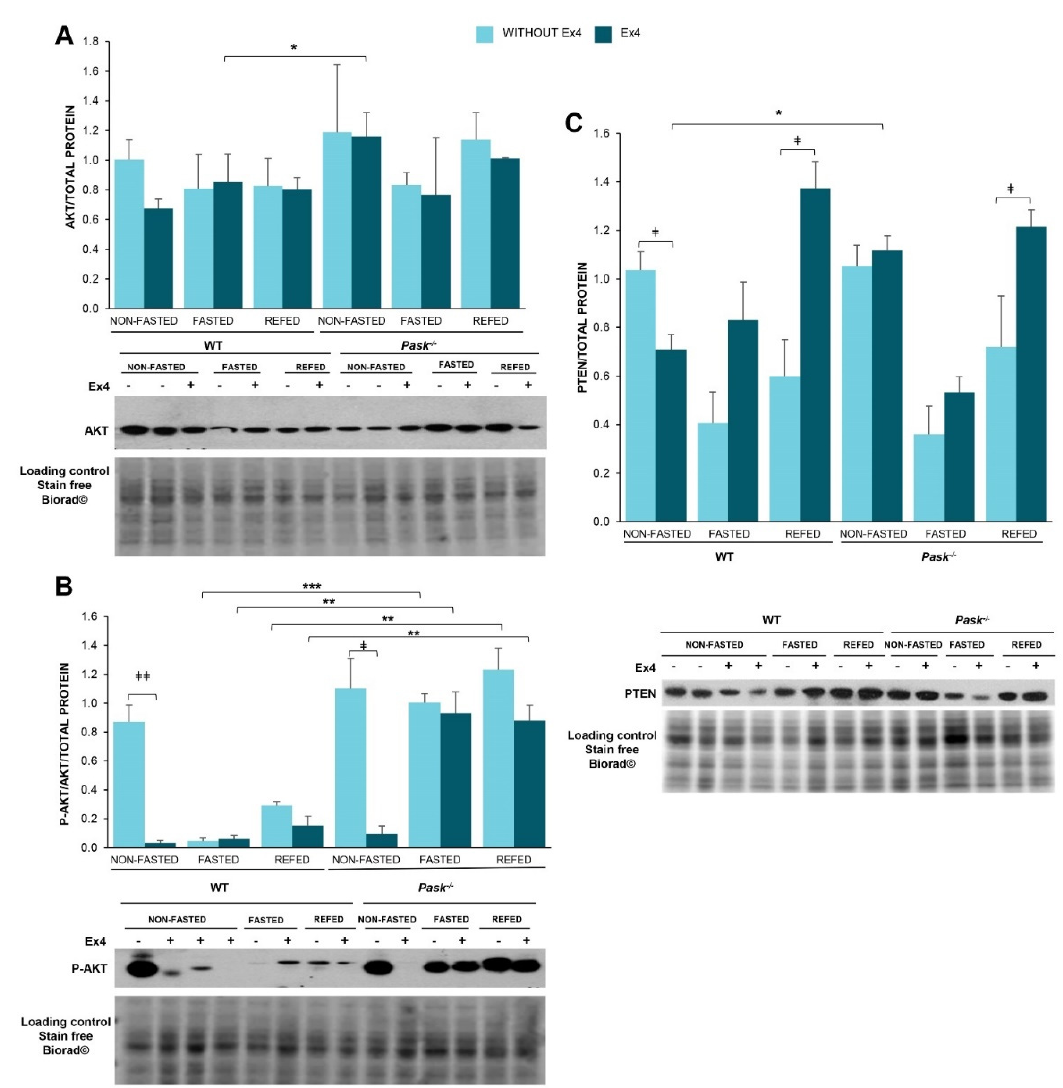
Figure 6. Exendin-4 and PASK-deficiency alter the adjustment of the insulin signaling pathway to fasting or refeeding states. Immunoblot analysis of phospho-AKT (Ser 473) (P-AKT) and total AKT (AKT) ( A , B ) as well as total PTEN (PTEN) ( C ) in the liver from wild-type (WT) and PASK-deficient mice ( Pask − / − ). Liver lysates from non-fasted (NON-FASTED), 48-h fasted (FASTED) and 3-h refed (REFED) specimens in the presence or absence of exendin-4 (Ex4) were processed for Western blot analysis. The values were normalized by total protein detected by Stain-Free Biorad© and expressed as fold-over the non-fasted wild-type mice. A representative blot of 2 prepared blots is also shown, from which the data shown in the graph were collected. Bar graphs show mean ± SEM of 3–5 animals per condition and expressed by fold-over the non-fasted wild-type mice; * p < 0.05, ** p < 0.01, *** p < 0.001 WT vs. Pask − / − and ‡ p < 0.05, ‡‡ p < 0.01 vehicle vs. exendin-4 by two-way ANOVA followed by Tukey post-hoc test.